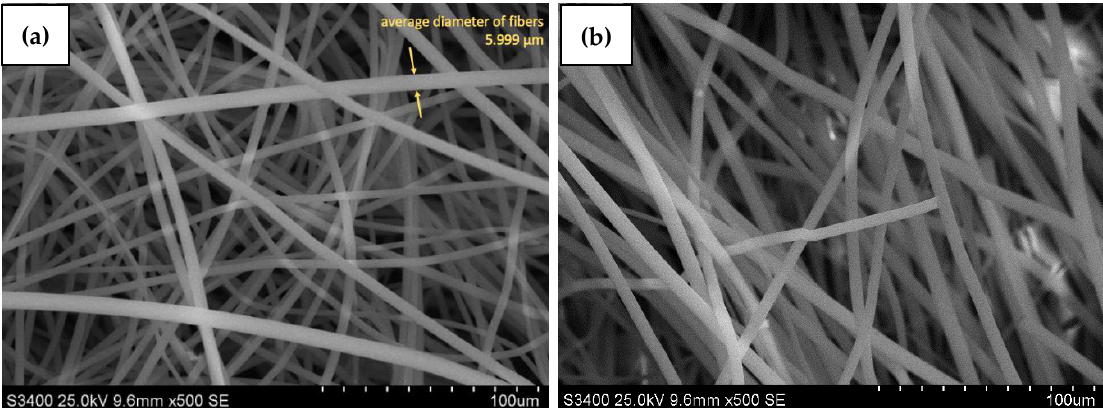
Figure 3. Top-view SEM pictures of PS nanofibers ( a ) and PS nanofibers with alginate immobilized bacteria ( b ) with a magnitude of 500.